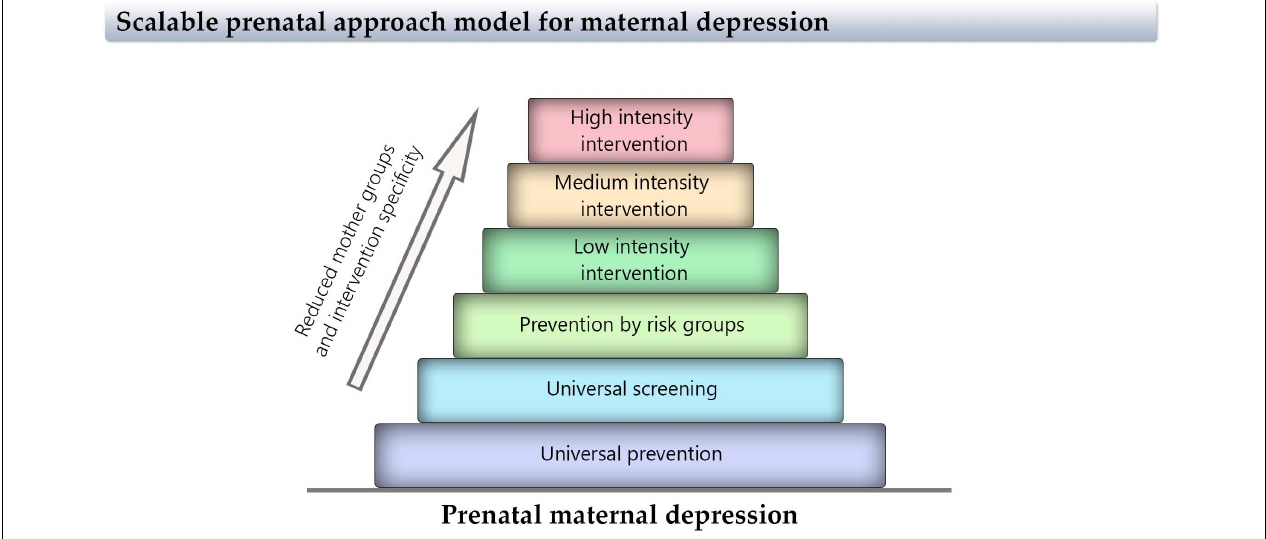
FIGURE 6 | Scale of proposed approaches for maternal depression interventions. This pyramid represents the size of the interventions for maternal depression, indicating that the basis should be attended wide and escalating over more specific groups and